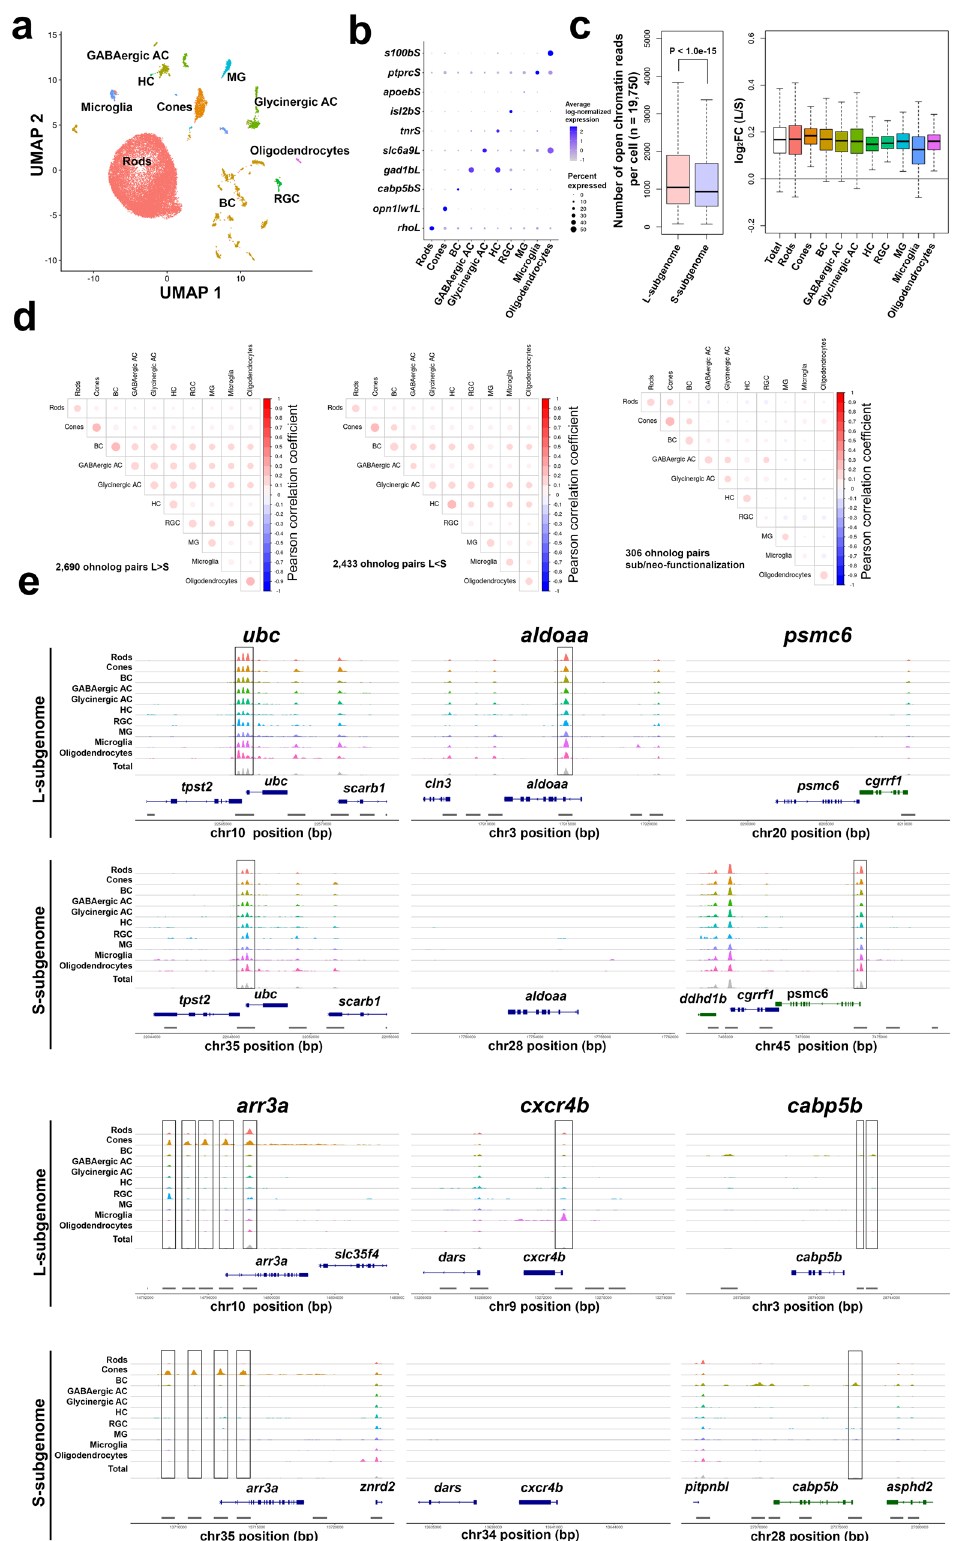
regions of the known cell-type marker genes (Fig. 6b). The pro- motor regions of L-ohnologs showed higher overall accessibility than those of S-ohnologs in all cell types (Fig. 6c, left panel). Moreover, for each cell type, the promotor regions of L-ohnologs showed higher overall accessibility than those of S-ohnologs (Fig. 6c, right